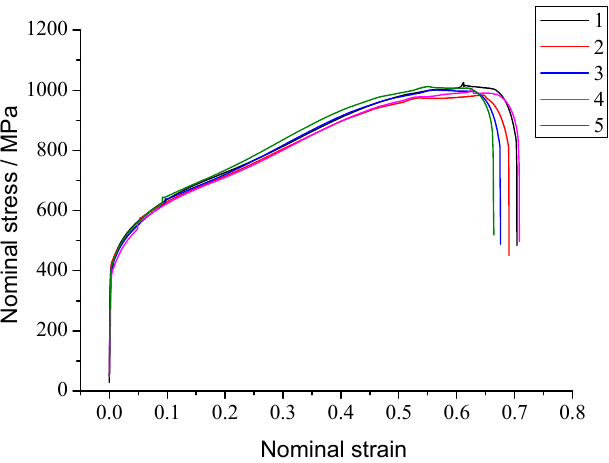
Figure 2. Nominal stress–strain curve of the GH1140 superalloy.